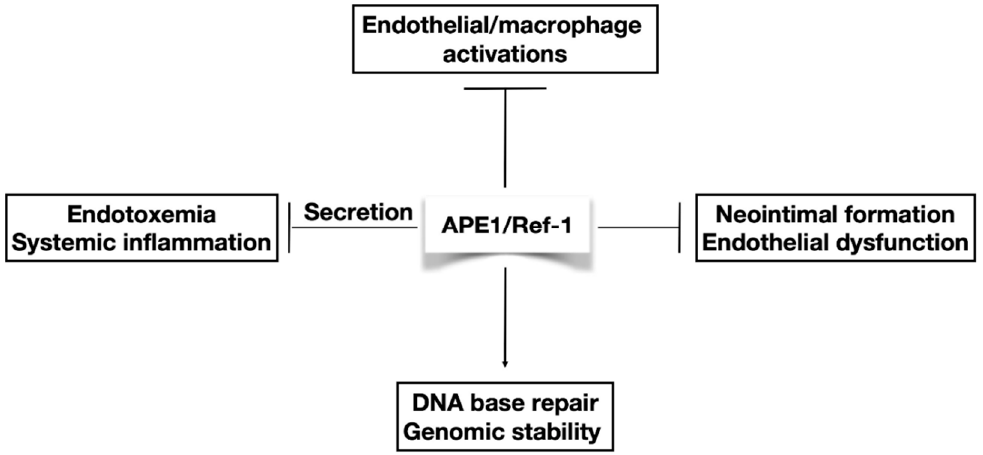
Figure 1. The role of apurinic/apyrimidinic endonuclease 1/redox factor-1 (APE1/Ref-1) in endothelial activation and systemic inflammation. Heterozygous APE1/Ref-1 mice showed endothelial dysfunction and hypertension [19]; gene transfer of APE1/Ref-1 inhibited neointimal formation of rat carotid arteries and inhibited endothelial activation in endothelial cells [18,23]. The secretory APE1/Ref-1 inhibited proinflammatory cytokines and inflammation in lipopolysaccharide-treated mice [22]. APE1/Ref-1 functions in DNA base repair and is essential for genomic stability. The arrow and T-bar represent activated and inhibitory interactions, respectively.